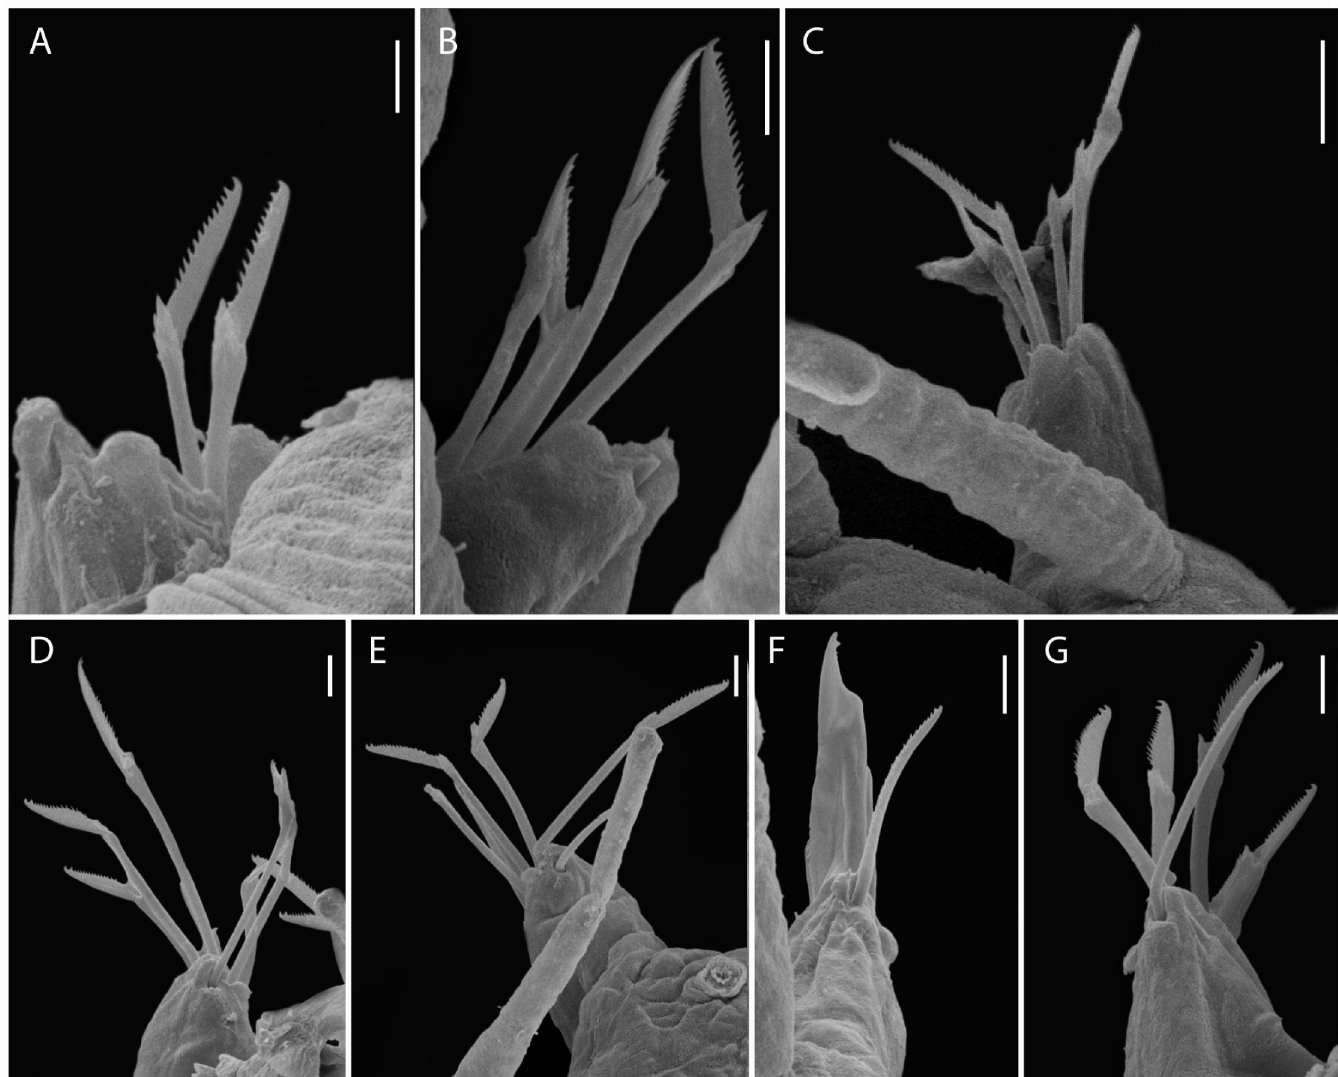
Fig 9. Salvatoria marielleae n. sp., paratype 3 (MZUSP 3593), SEM. (A–C). Falcigers, anterior body; (D–E). Falcigers, midbody; (F–G). Falcigers and dorsal simple chaetae, posterior body. Scale bars: A–B, 4 μ m; C, 10 μ m; D–G, 6 μ m.